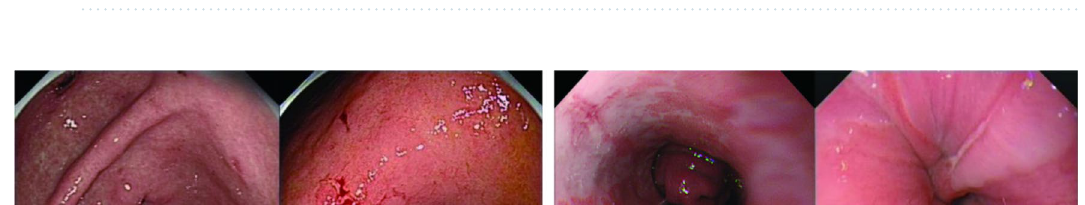
Table 4. Esophageal image label error screening results.